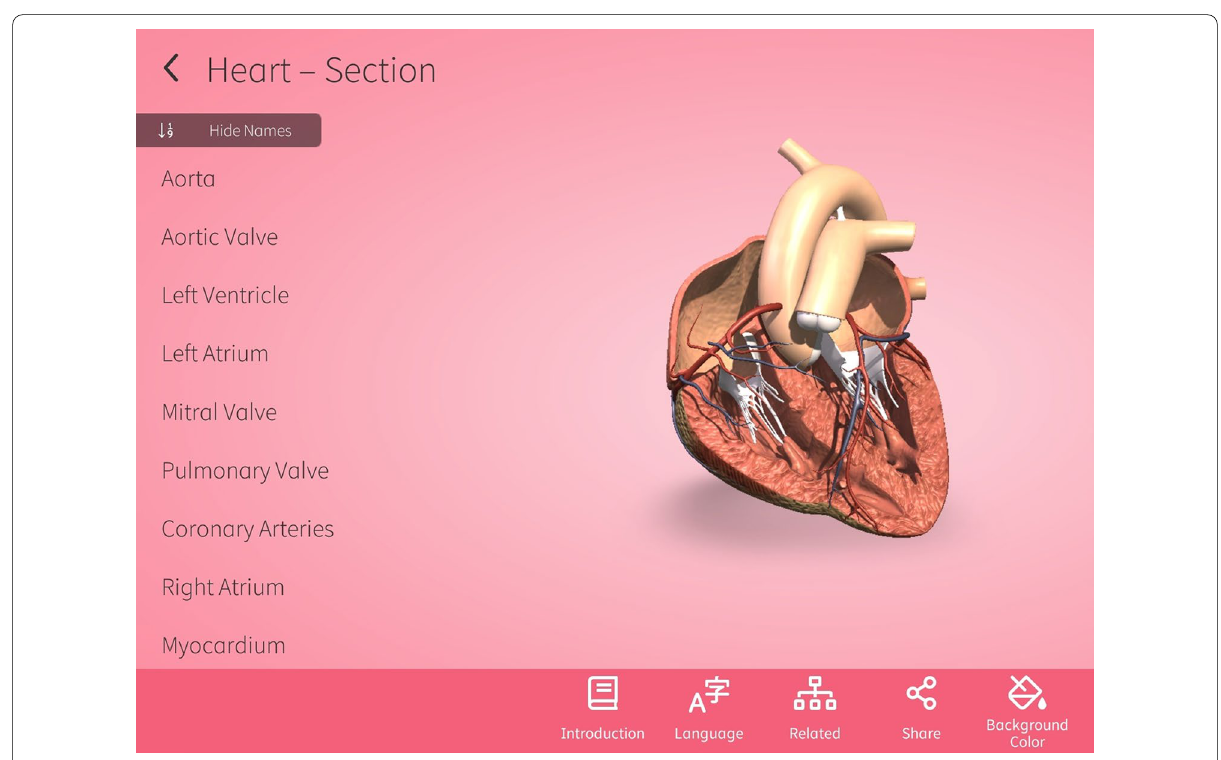
Fig. 1 One of the models used in experimental teaching—a 3D model of the heart (Corinth s.r.o.,